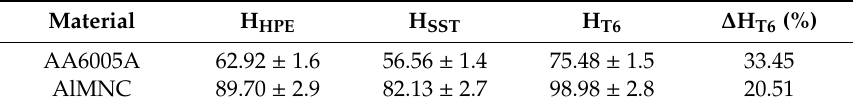
Table 4. Vickers microhardness ( µ HV 100 ± S.D.) of the AA6005A and AlMNCs milled powders in as-extruded (HPE), as-solid-solution-treated (SST) and aged-hardening (T6) conditions, and